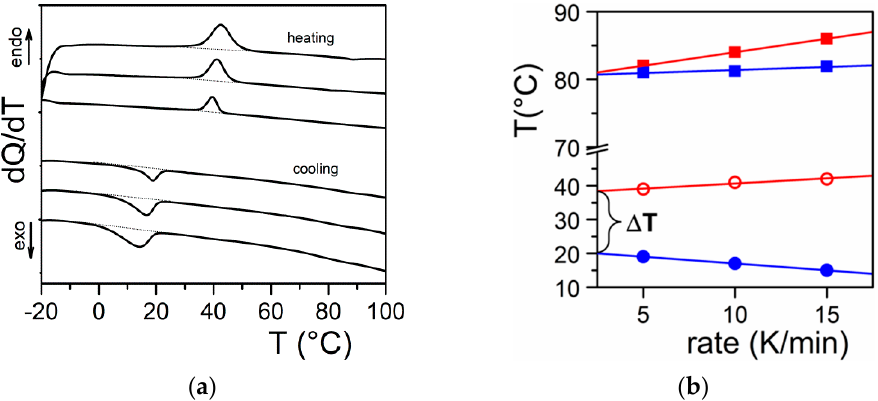
Figure 2. ( a ) DSC thermograms obtained on heating (endo) and on cooling (exo). Scanning rates 5, 10, and 15 °C/min; ( b ) variation of the melting peak peak ( ) and the formation peak ( ) for Tri-aryl-triamine/tetrachloroethane organogel (C = 0.02 g/g). ( ) and ( ) stand for pure naphtha- lene for the sake of comparison.